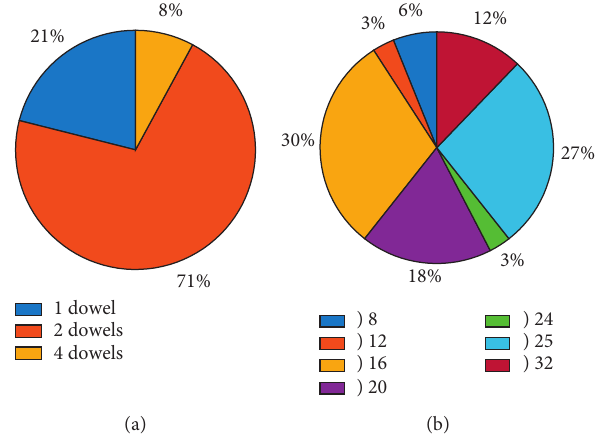
Figure 23: Dowels in beam-to-column connections (a) number and (b)